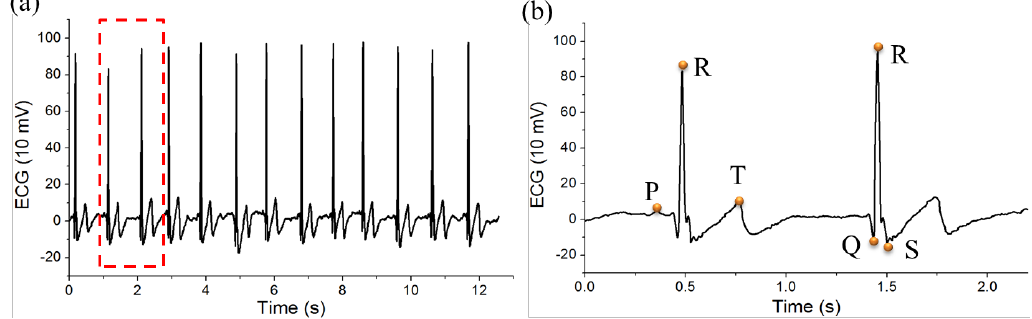
Figure 6. ECG signal analysis: ( a ) raw ECG data plot; ( b ) ECG graph for QRS detection.